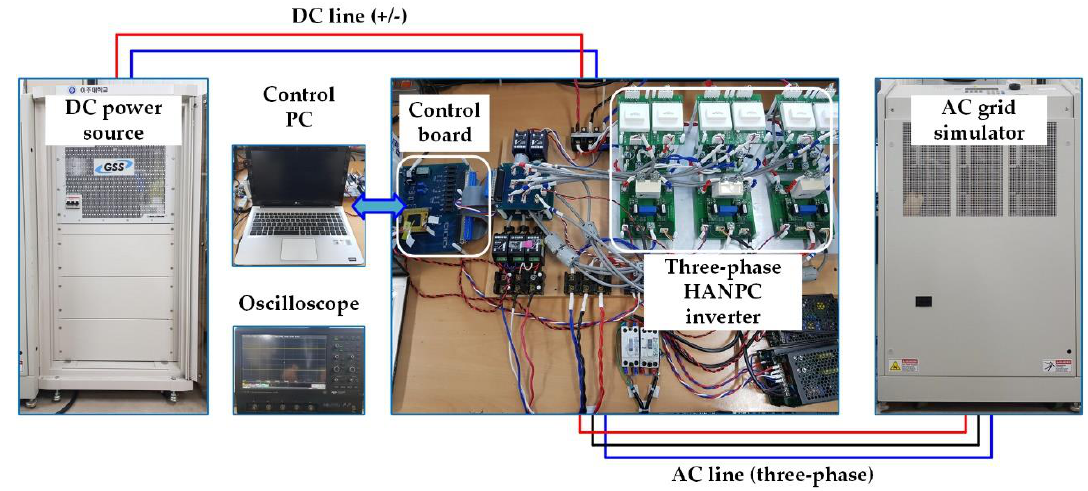
Figure 12. Experimental set-up of three-phase grid-connected HANPC inverter.